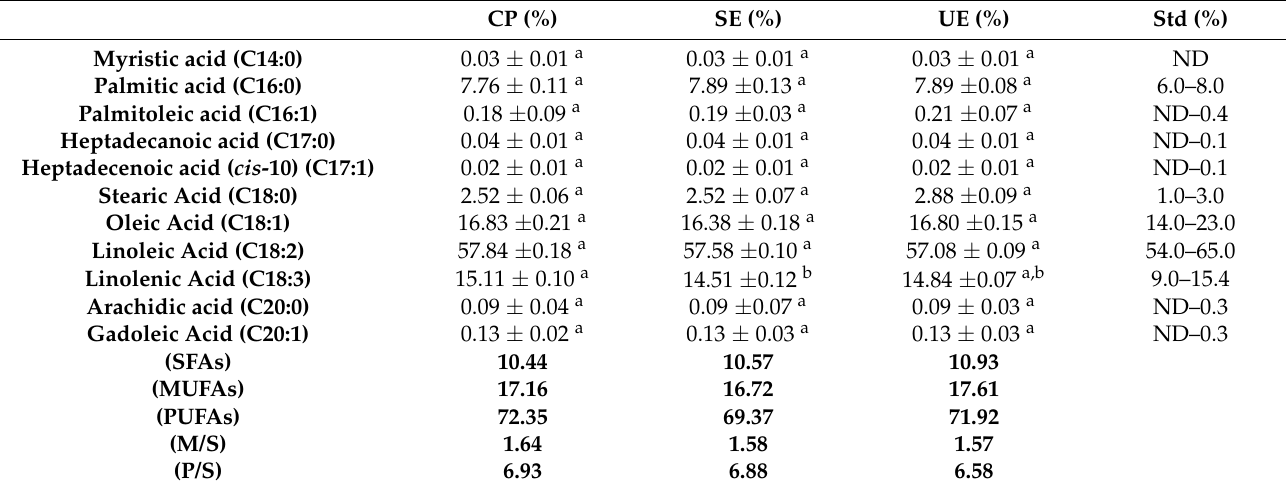
Table 2. Fatty acid compositions of walnut seed oils extracted by different methods (Mean ±